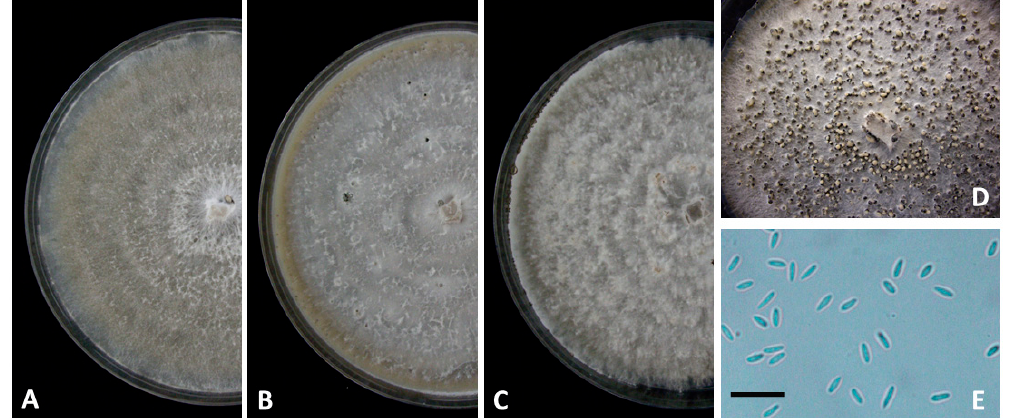
Figure 3. Diaporthe mediterranea (DAL-34). ( A – C ) Colonies on Malt Extract Agar (MEA), Oat Agar (OA) and Potato Dextrose Agar (PDA), respectively; ( D ) conidiomata sporulating on PDA; ( E ) alpha conidia—scale bar = 20 μ